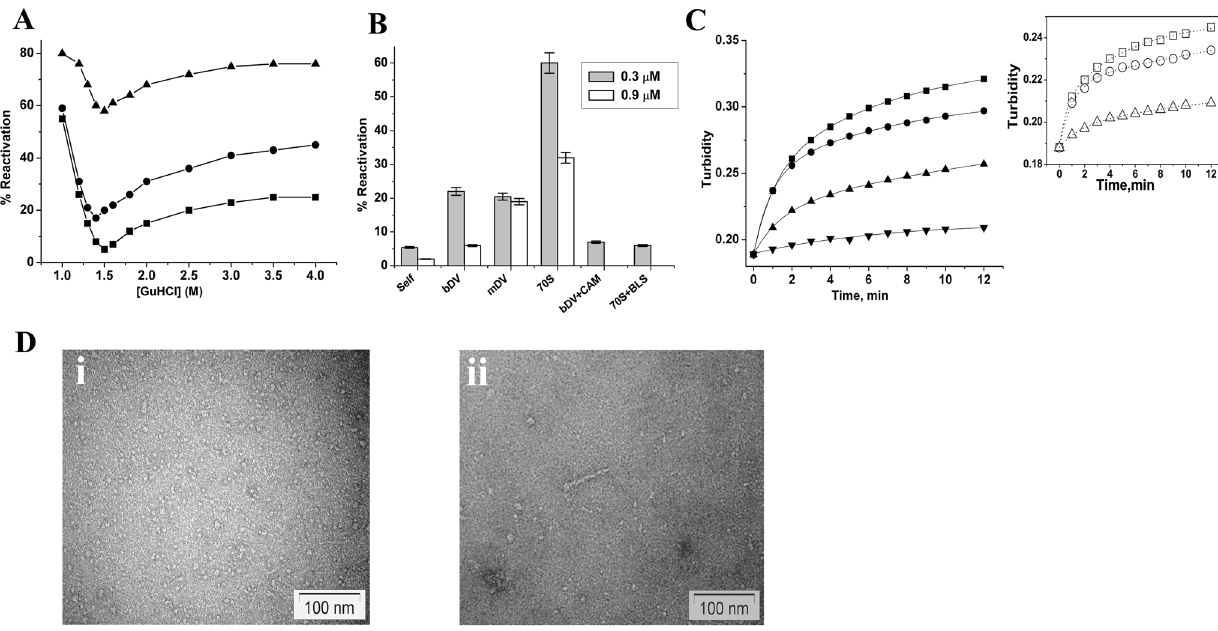
N -). B) Bar graphs showing